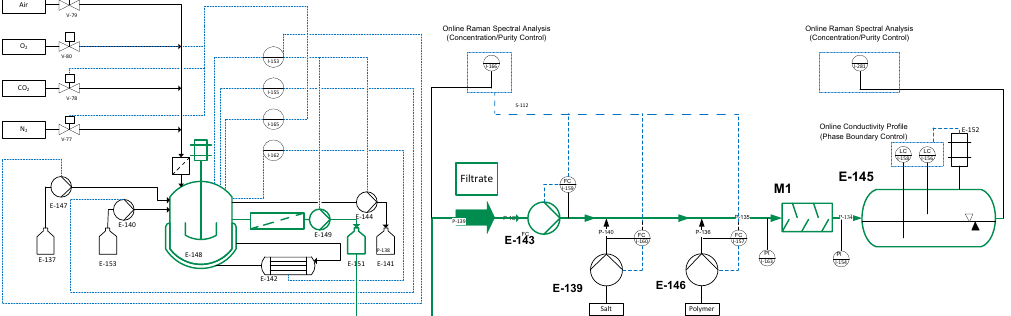
Figure 18. Proposed control strategy for USP and ATPE. A Raman probe is used as (PAT) at the filtrate outlet of USP and forwards mAb and side component concentrations to the ATPE, which adjusts the polymer and salt concentrations to produce light phase with a constant mAb concentration which is then forwarded to the precipitation unit.